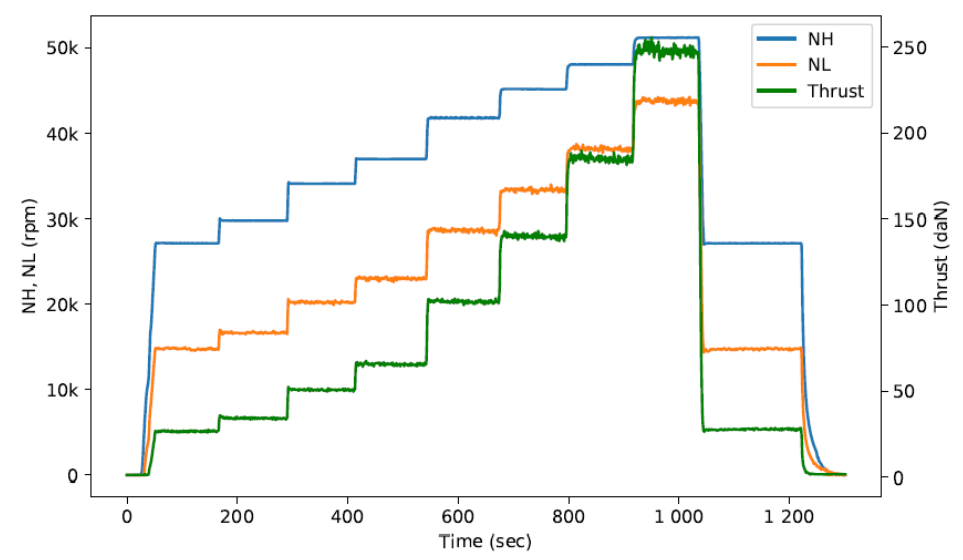
Figure 10. Engine test profile for DGEN